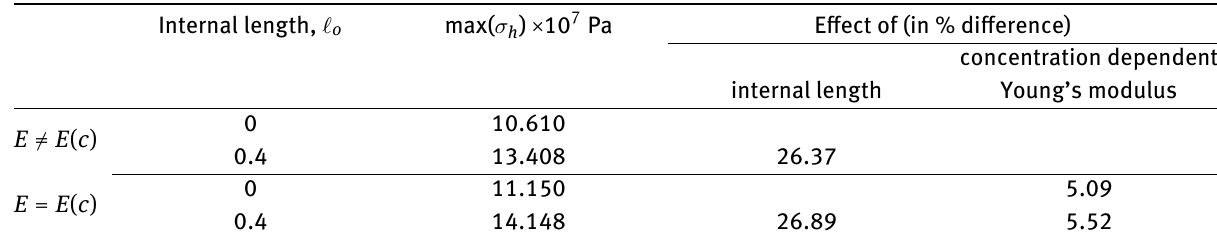
Figure 2: Influence of internal length on the evolution of the concentration, radial displacement, radial stress and hydrostatic stress at the center of a spherical particle. Table 1: Effect of internal length and the concentration dependent Young’s modulus on the maximum hydrostatic stress experienced by the particle of radius a = 20 𝜇